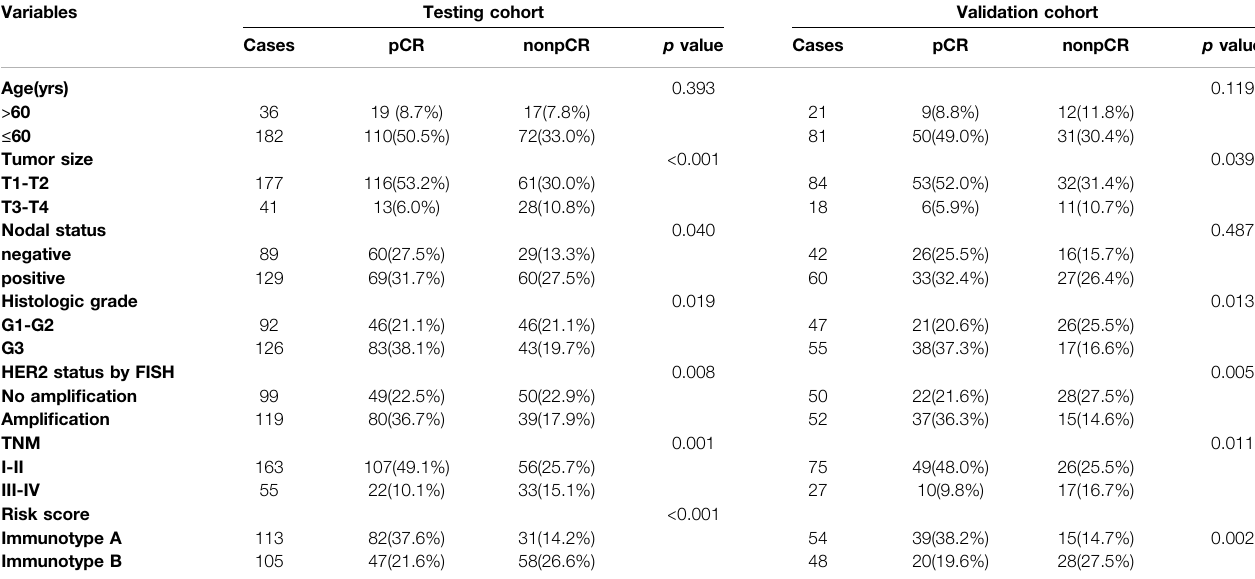
TABLE 2 | The relationship between pCR and clinicopathologic characters in testing cohort and validation cohort.